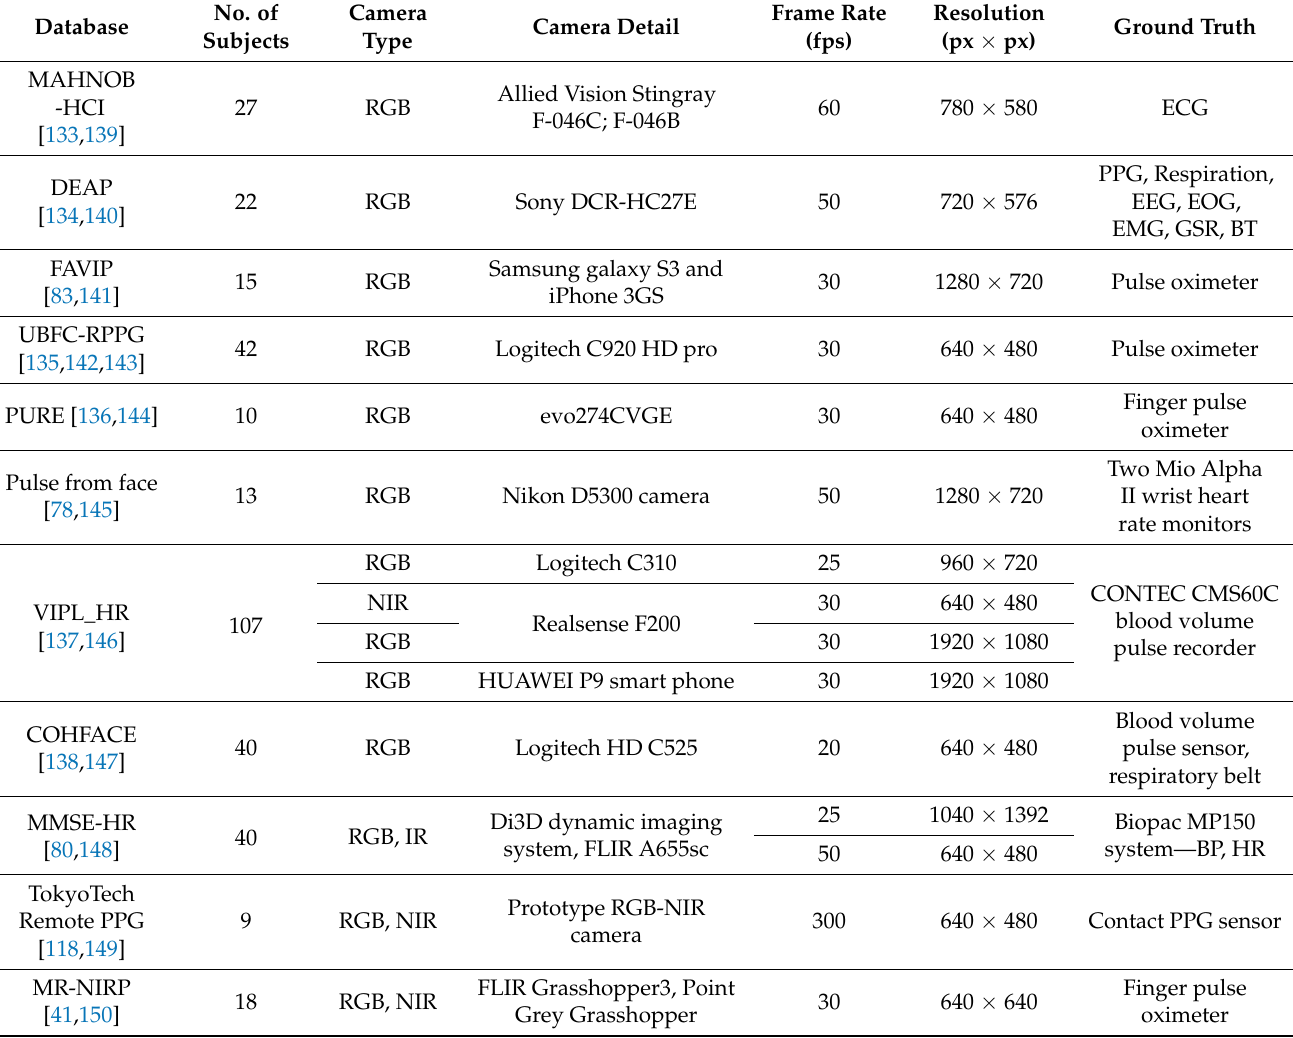
Table 2. Existing